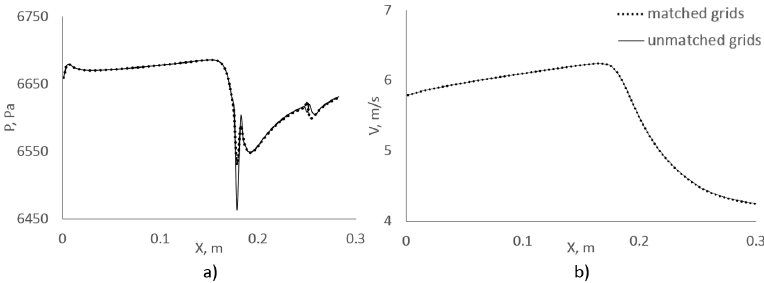
Figure 17. Profile of velocity module ( a ) and pressure ( b ) along the channel.